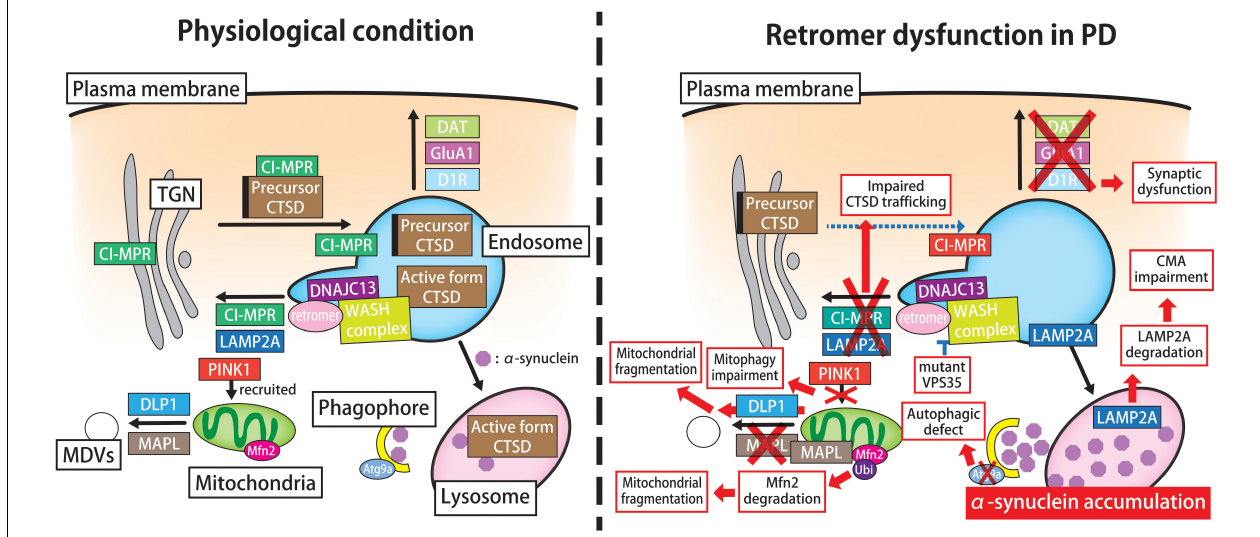
FIGURE 3 | Retromer-mediated pathogenic pathway in PD. In physiological states ( left panel ), the retromer participates in the activation and CI-MPR-mediated sorting of CTSD, a major lysosomal hydrolase for α -syn degradation. The clearance of neurotoxic α -syn species largely depends on the autophagy-lysosomal pathway, especially macroautophagy and CMA. Retromer modulates the retrograde transport of LAMP2A, a receptor for CMA, from endosomes to the TGN, thereby preventing its degradation in lysosomes. In addition, retromer regulates the surface recycling of GluA1, D1R and DAT and thus influences synaptic function. Furthermore, retromer might participate in the autophagic machinery and mitochondrial dynamics, which are key processes in the maintenance of neuronal homeostasis. In the PD brain ( right panel ), retromer function is disturbed by aging, environmental toxin exposure, or genetic alterations. The familial PD-linked mutant VPS35 disrupts the molecular interaction between VPS35 and the WASH complex, which hampers retromer-mediated cargo sorting to the TGN. The perturbation of endosome-TGN trafficking hampers CTSD trafficking, thereby leading to abnormal α -syn accumulation in lysosomes. Likewise, retromer failure impairs the endosome-to-TGN retrieval of LAMP2A and accelerates its degradation in lysosomes, which compromises the CMA-mediated degradation of cytotoxic α -syn. Moreover, mutant VPS35 causes autophagic failure, which is partly explained by the mislocalization of autophagy protein ATG9A. Additionally, retromer failure increases the expression level of GluA1 and D1R on the plasma membrane, and thus induces synaptic dysfunction. In addition, mutant VPS35 has detrimental effects on mitochondrial fission-fusion dynamics and PINK1-PARKIN-mediated mitophagy, which results in mitochondrial dysfunction and fragmentation. The PD-linked DNAJC13 mutation influences on the trafficking of multiple cargoes possibly due to the alteration of the membrane dynamics via retromer-related WASH complex and SNX1. CI-MPR, cation-independent mannose-6-phosphate receptor; CTSD, cathepsin D; CMA, chaperone-mediated autophagy; LAMP2A, lysosomal-associated membrane protein 2A; TGN, trans -Golgi network; D1R, dopamine D1 receptor; DAT, dopamine transporter; PD, Parkinson’s disease; VPS, vacuolar protein sorting; WASH, Wiskott-Aldrich Syndrome protein and scar homolog; ATG, autophagy-related; PINK1, PTEN-induced putative kinase 1; SNX sorting nexin; DNAJC13, DnaJ heat shock protein family (Hsp40) member